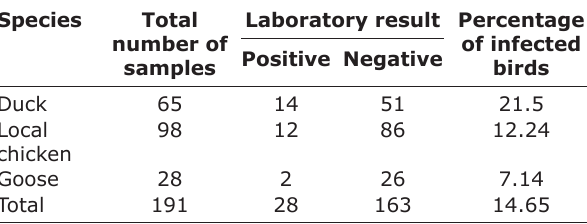
Table-3: The positive result of avian influenza in different species in live bird markets in Tripoli. Species Total number